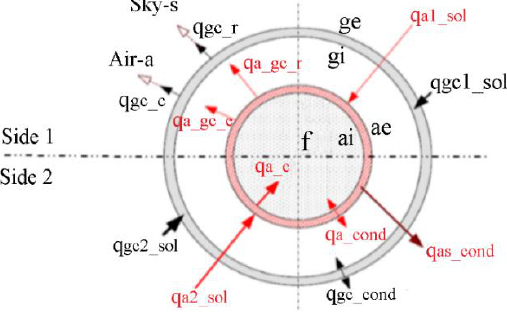
Figure 3. Heat transfer model used to evaluate the thermal losses of the receiver, adapted from [21]. Side 2 of the receiver tube faced the collector to receive concentrated solar irradiation.